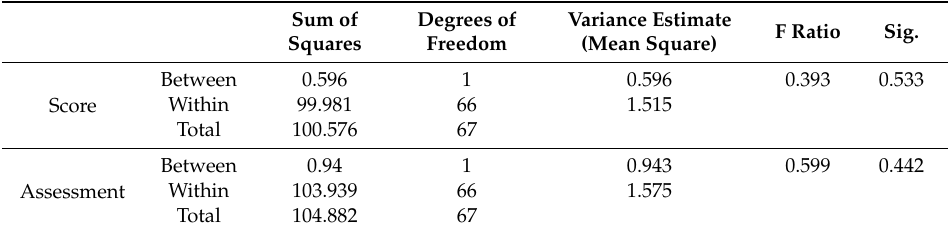
Table 6. Results of the ANOVA analysis for testing the significance of type of course.